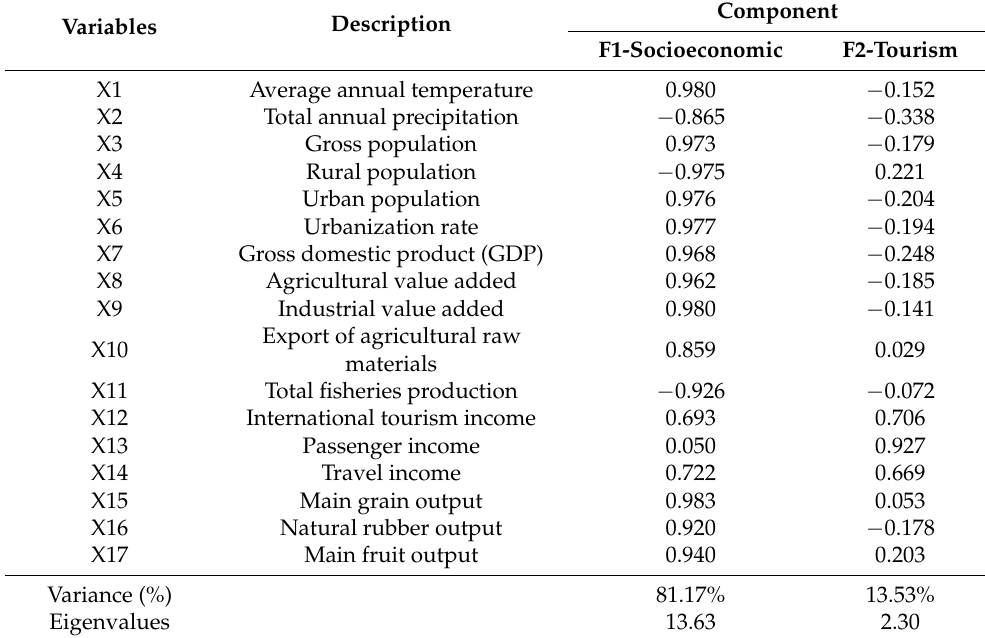
Table 4. Rotated component matrix of the principal component analysis.